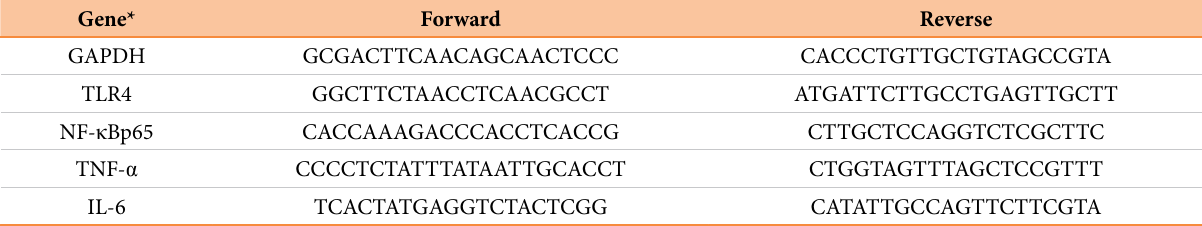
Table 1 - Primer sequences of target genes for real-time PCR in the